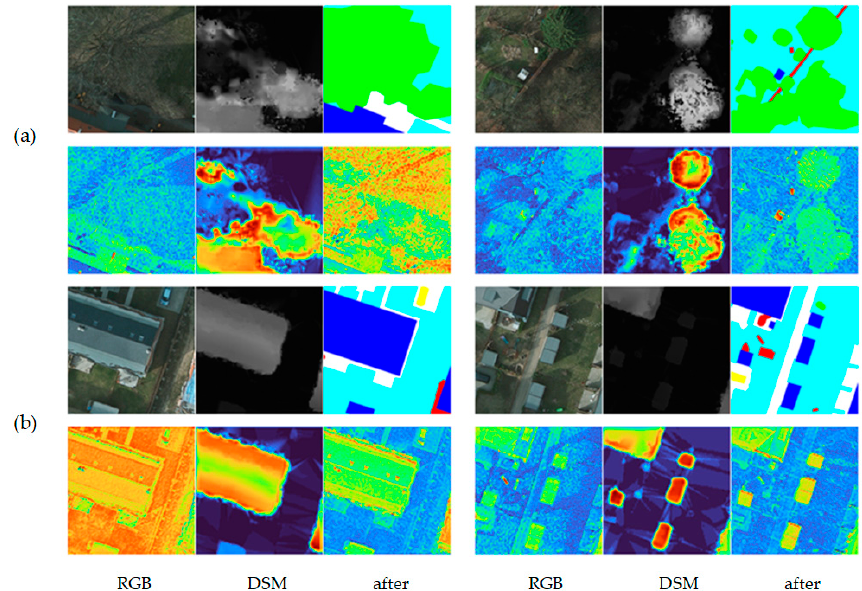
Figure 8. The figure contains the RGB images, the DSM images, and the feature maps after feature extraction, and the feature maps after the feature fusion module, aligned in the columns with the GT (ground truth) images. ( a ) The visualization focuses on the trees; ( b ) The visualization focuses on the